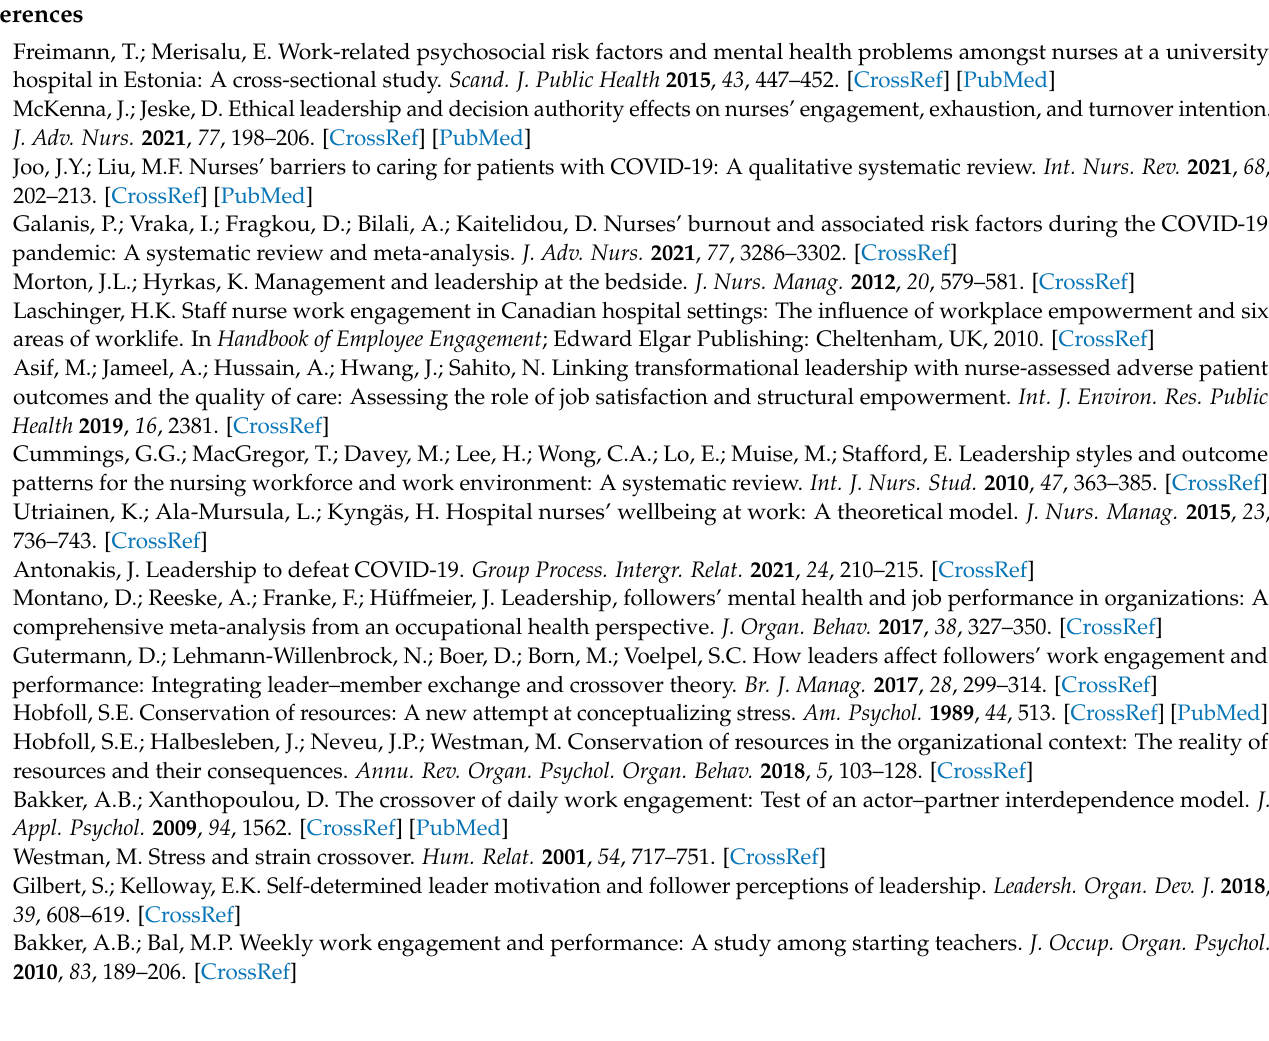
Figure A1. Results of Model 1 with standardized estimates. Note: * p < 0.05; ** p < 0.01; *** p < 0.001. Discontinuous lines indicate non-significant relationships.